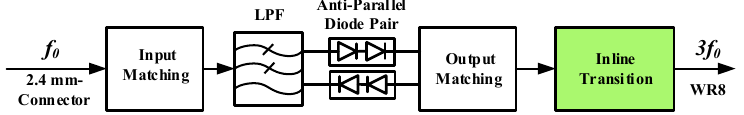
Figure 12. Circuit diagram of 110 GHz tripler with new probe structure [75].